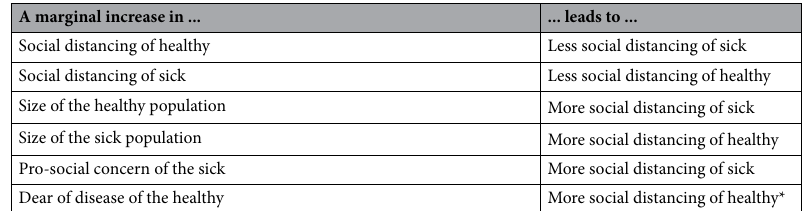
Table 1. Comparative statics of the equilibrium analysis. These describe how optimal contact rates vary with the other parameters, evaluated under the assumption that a symmetric Nash equilibrium exists such that β i = β H for all healthy and β i = β S for all sick. See Supplementary Information ‘Comparative Statics Derivations’ for details. *Present in the model by Ref. 45 . The other effects are new herding, etc. as proposed, for example, in 11,59